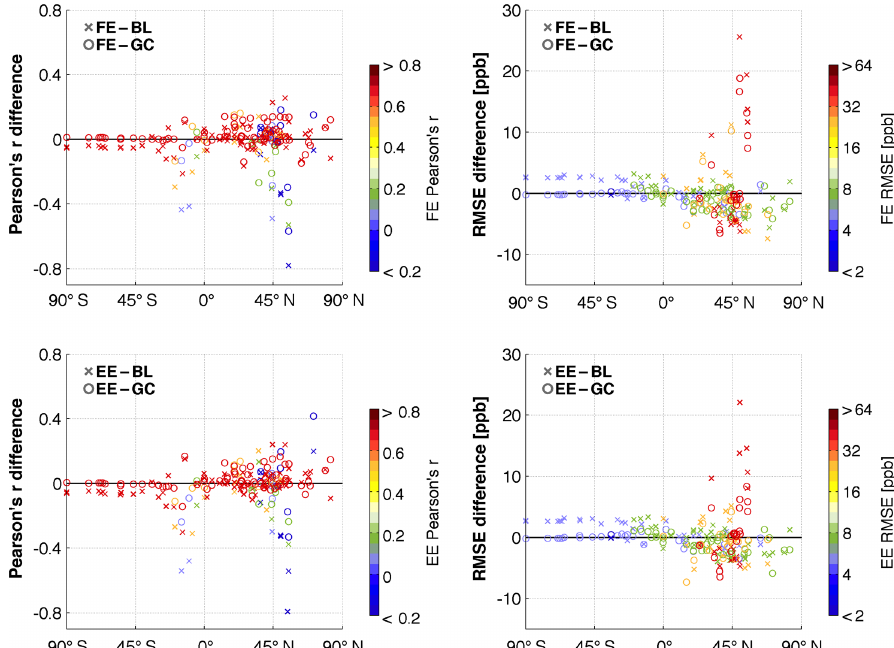
Figure 9. The symbol colours denote the monthly de-trended CH 4 Pearson’s r correlation (left column) for the model observations and RMSE (right column) for the FE (top row) and EE (bottom row) wetland CH 4 emissions (monthly CH 4 observations are from the WDCGG measurement site network). The y axis denotes the difference between FE and EE and the model runs with Bloom et al. (2012) wetland CH 4 emissions (BL) and the GEOS-Chem wetland CH 4 emissions inventory